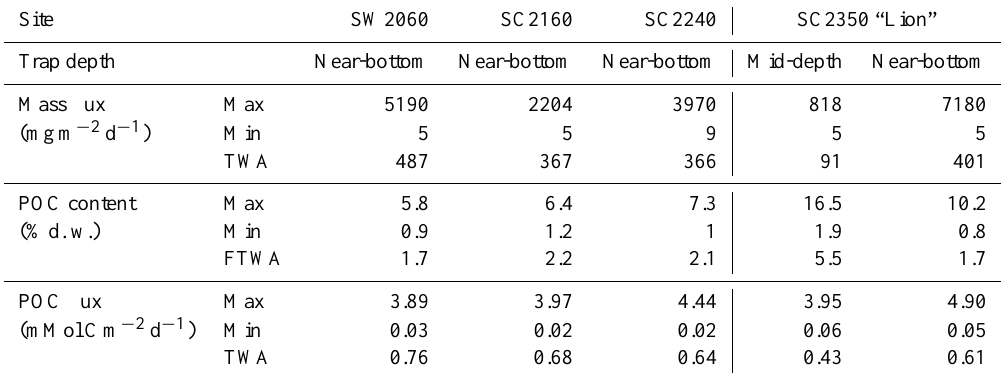
Table 5. Main statistics (maximum, minimum and mean) of mass flux, POC content and POC flux in SW2060, SC2160, SC2240 near- bottom traps and in SC2350 mid-depth and near-bottom sediment traps. Mean flux has been calculated as time-weighted average (TWA). Mean content has been calculated as flux and time weighted average